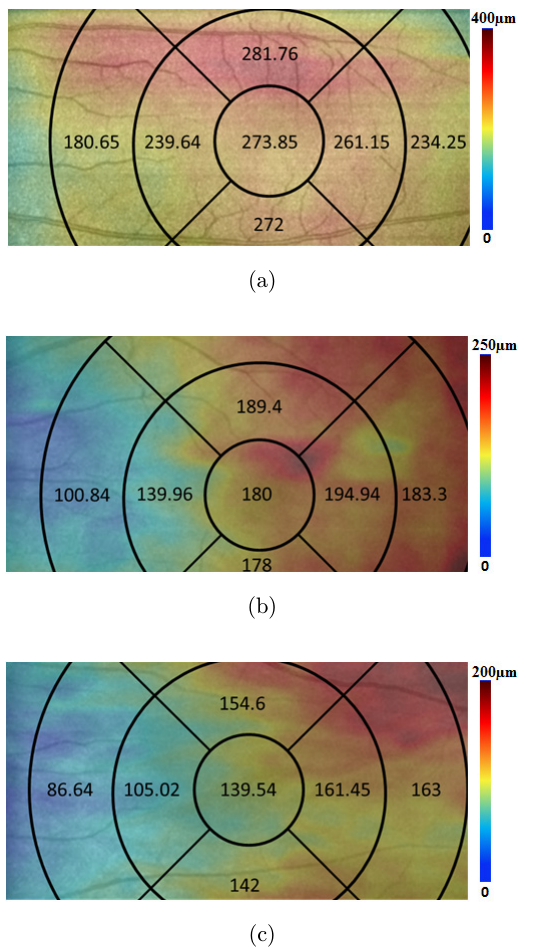
Fig. 6. The mean CT distribution in di®erent superior, infe- rior, nasal, and temporal quadrants under conditions of low (a), moderate, (b) and high myopia (c). Data are presented as the mean value.